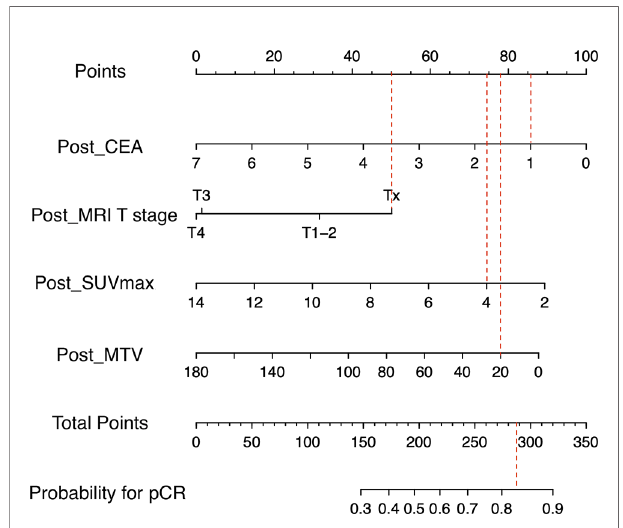
FIGURE 2 | Application of nomogram for a virtual